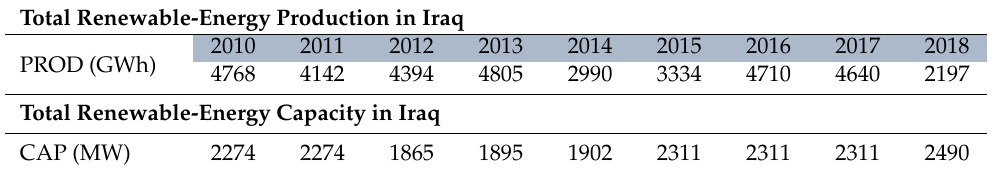
Table 3. Total renewable-energy production (PROD) and capacity (CAP) in